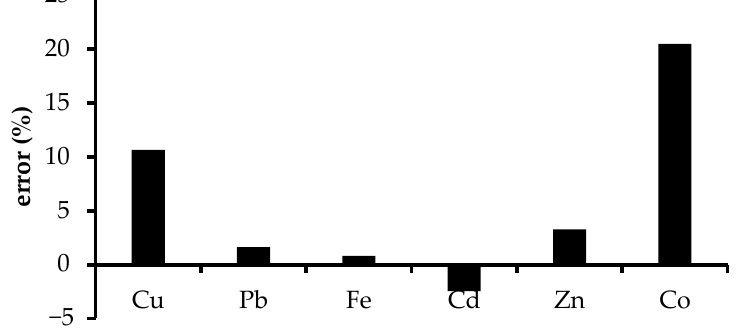
Figure 7. Effect of interference ions on the sensor response with ratio concentration of Ni 2+ and interference ions of 1:1.